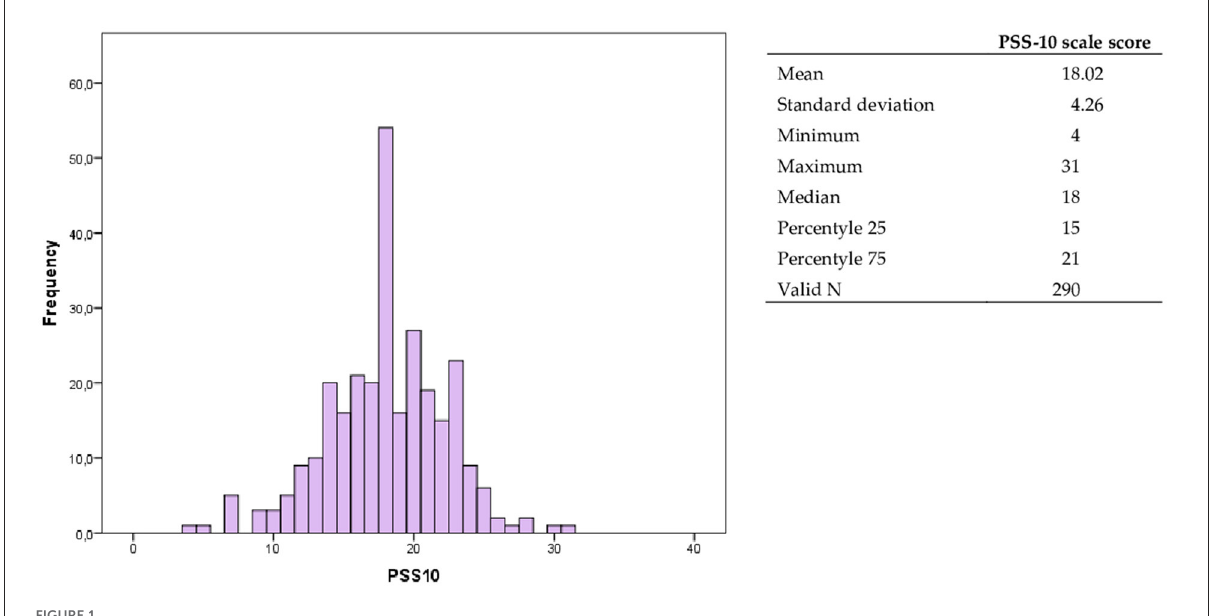
FIGURE1 Histogram of the PSS-10 scale.